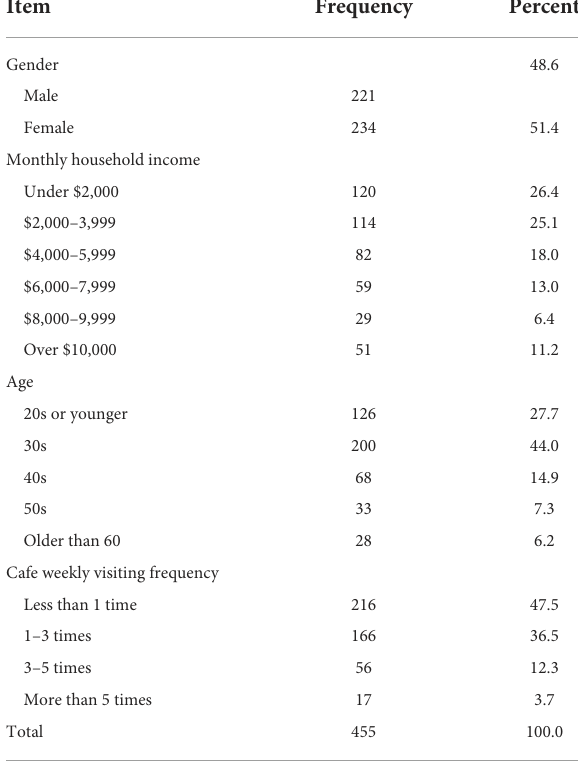
TABLE 2 Demographic profile of survey participants ( N =